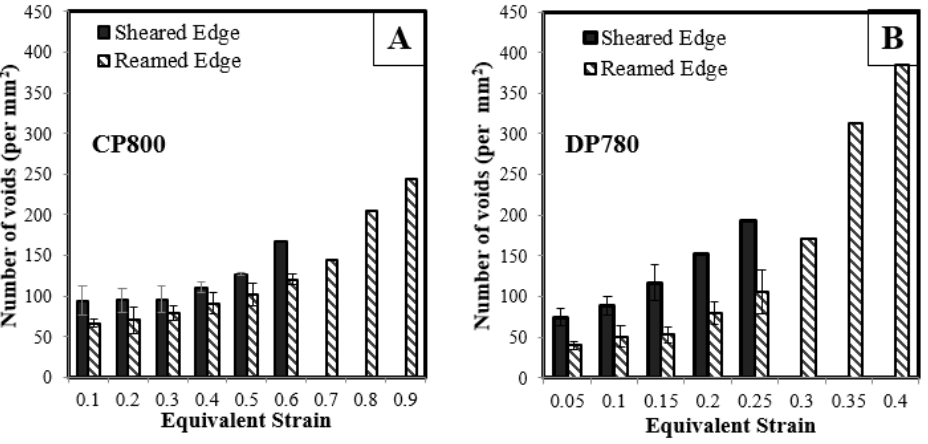
Figure 17. Average void density versus equivalent strain for ( A ) CP800; and ( B ) DP780. Note that the number of measurements at higher strain drops to unity so that a standard deviation cannot be calculated (no scatter bands).